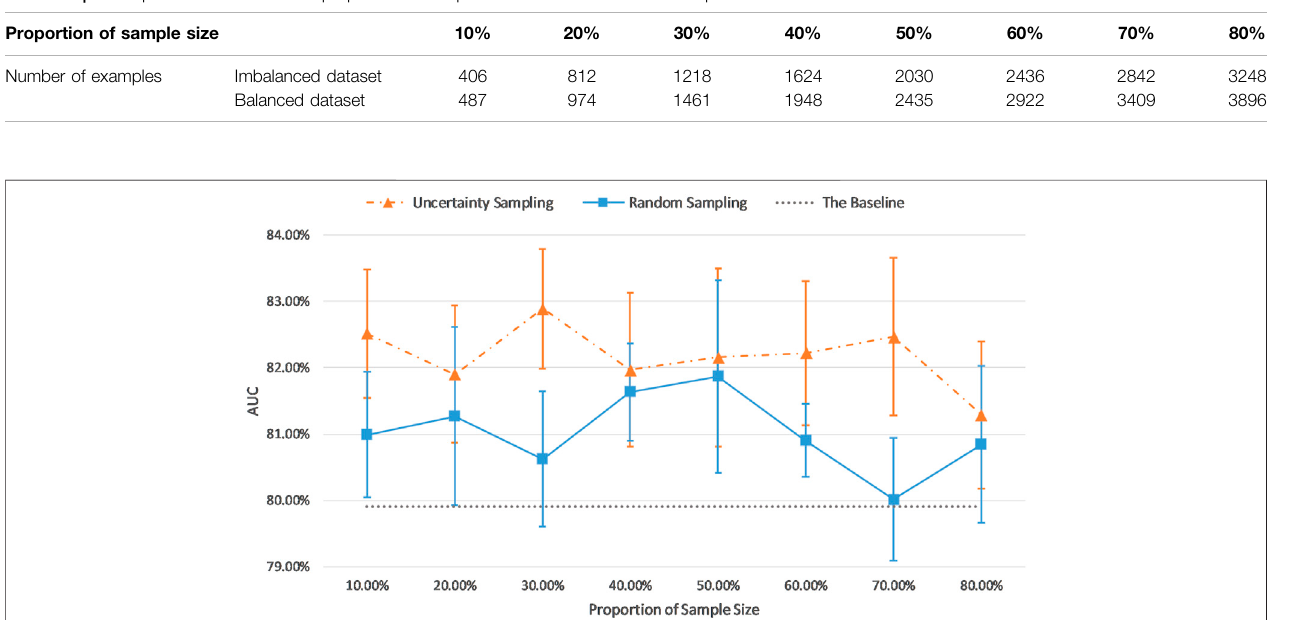
Frontiers in Arti fi cial Intelligence |